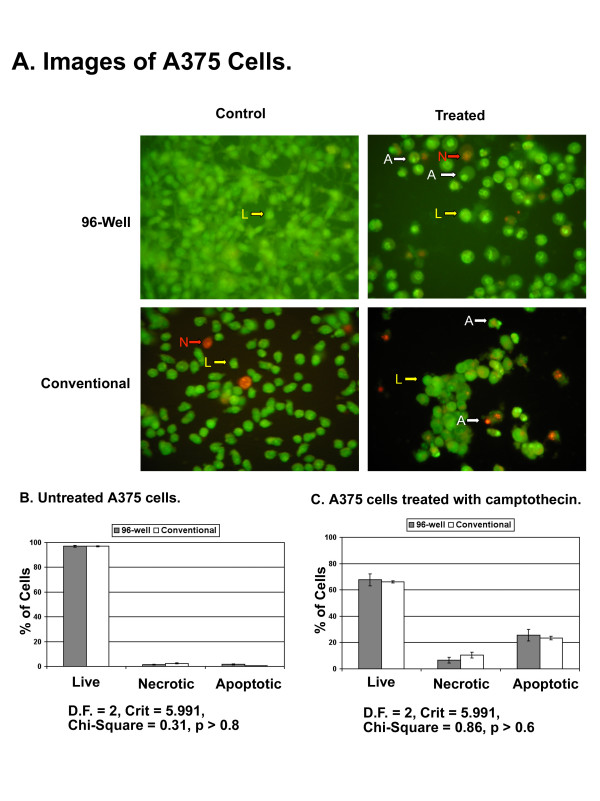
Comparison of a 96-well-based and the conventional EB/AO method for A375 adherent cells. A375 cells were treated with 6 μM camptothecin for induction of apoptosis. Symbols and labels are used in the same way as in Figure 1.